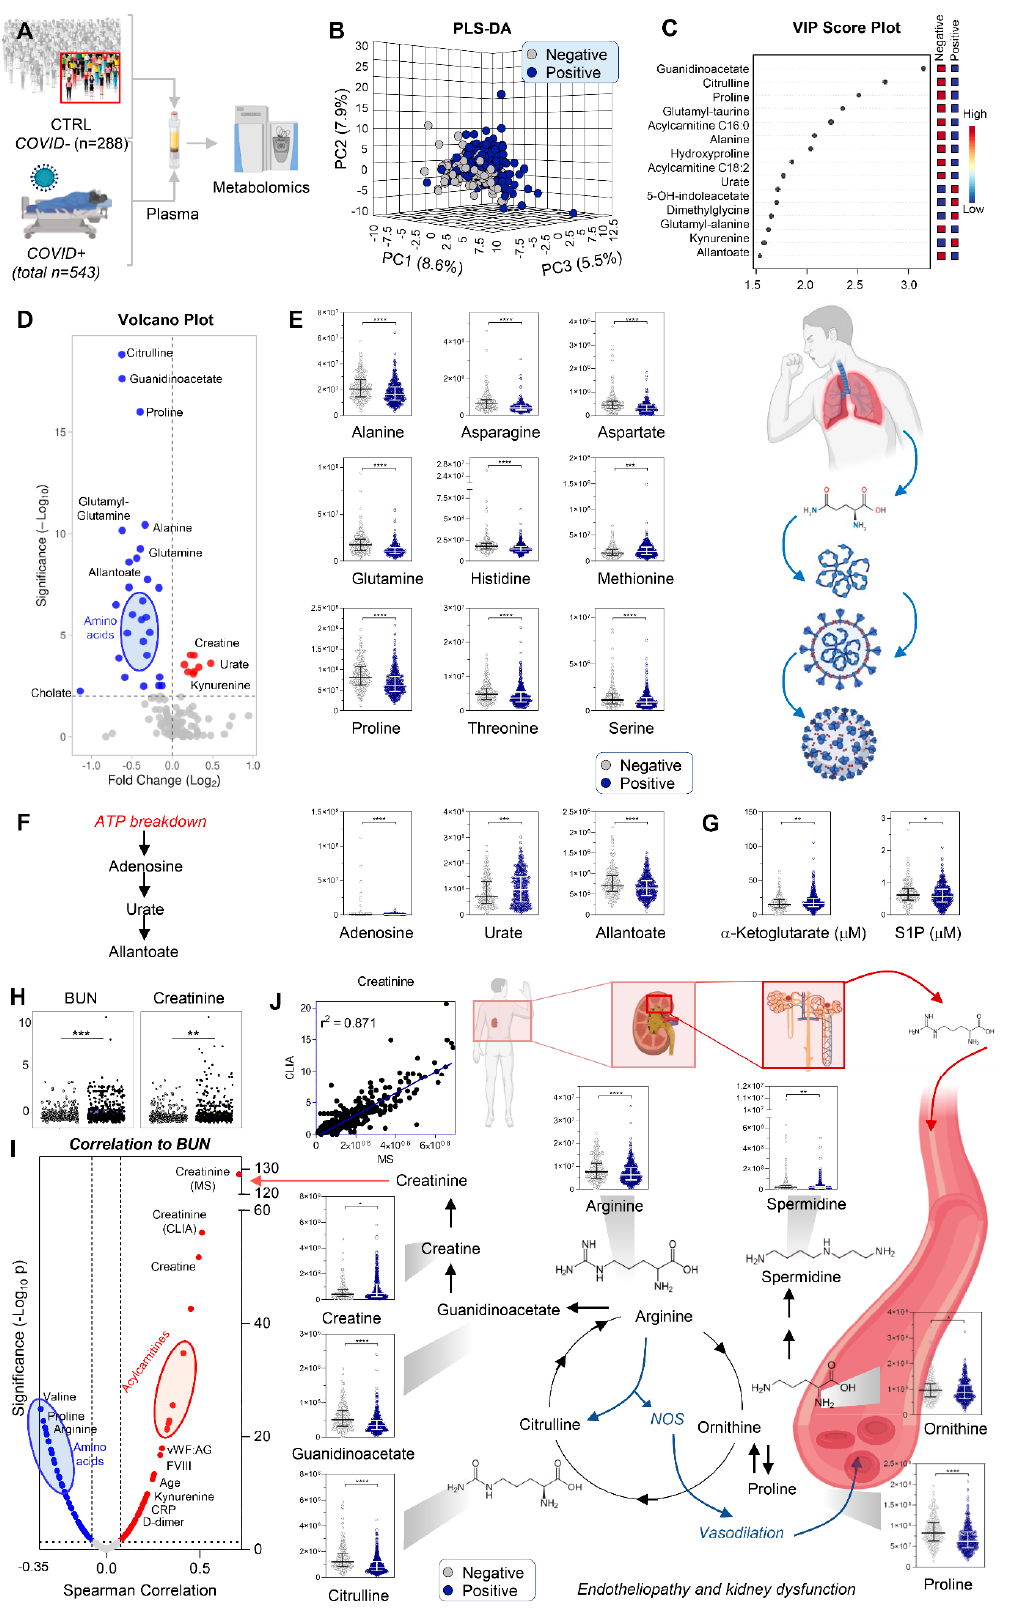
Figure 1. Metabolomics of hospitalized patients with (n = 543) and without (n = 288) COVID-19 ( A ). Partial least square- discriminant analysis of metabolomics data separated the two cohorts ( B ). Top 15 metabolites with the highest loading weights are indicated in the variable importance in projection (VIP) ranked list in ( C ). In ( D ), the volcano plot highlights significant effects of COVID-19 on plasma amino acid levels and purine oxidation. Violin plots (including median + ranges)